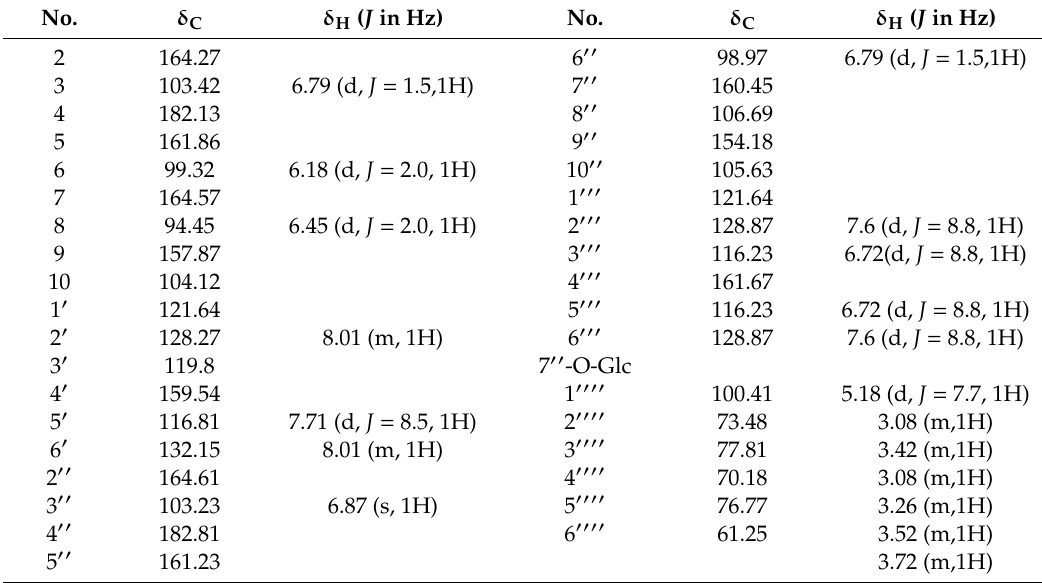
Table 2. 1 H-NMR (600 MHz) and 13 C-NMR (151 MHz) of compound 1 in DMSO- d 6 ( δ in ppm, J in